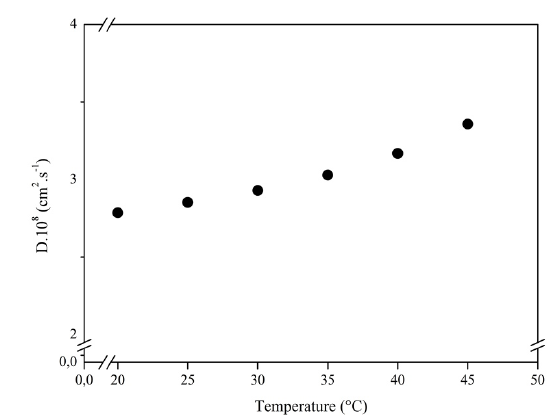
solubility coefficients in PSf membrane as a Figure 8 - CO 2 temperature function at 2